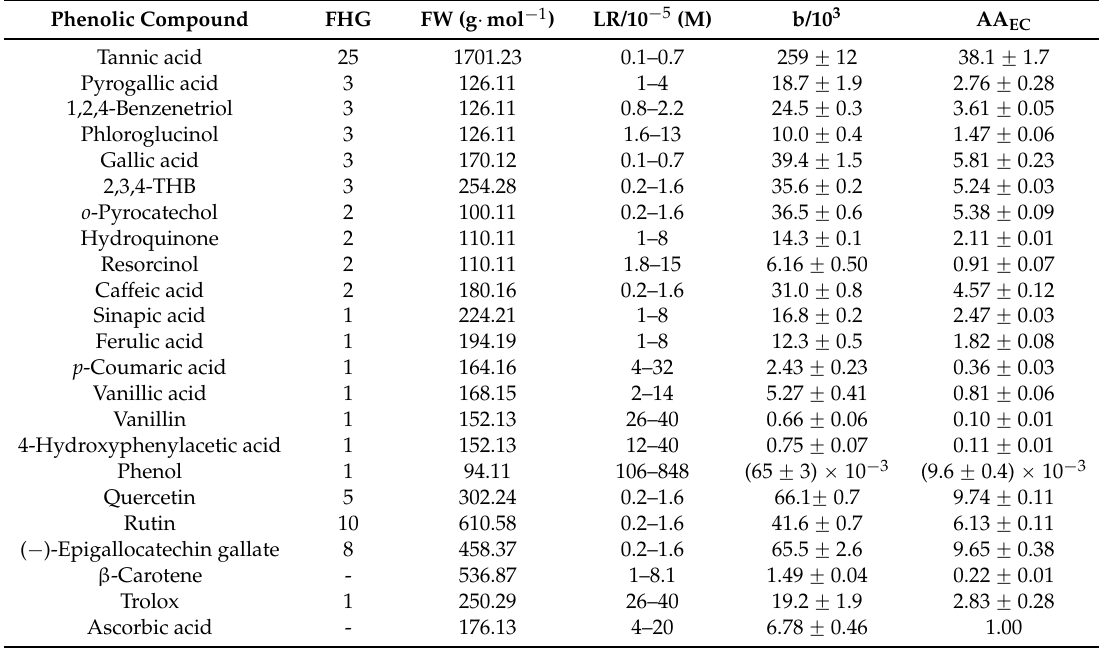
Table 1. Ascorbic acid equivalent capacity of antioxidant compounds obtained with the proposed method. Phenolic Compound